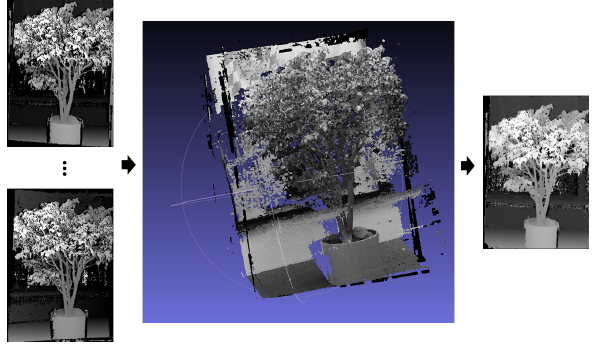
Figure 7. The reference disparity map generation